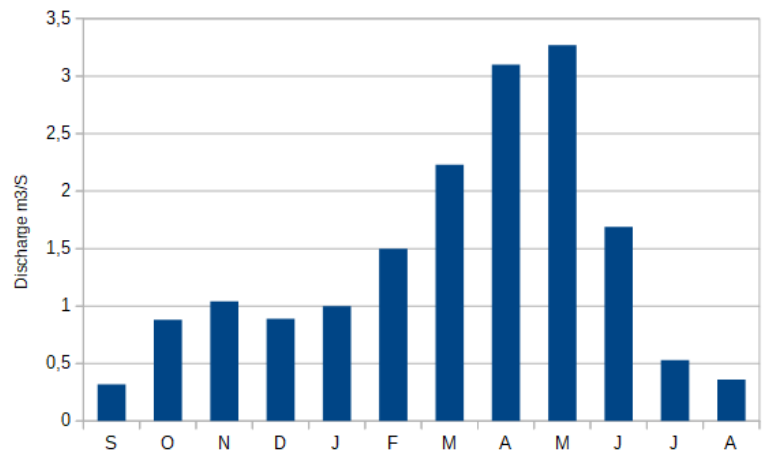
Figure 2. Mean monthly discharge (m 3 /s) of the Rheraya River at Tahanaout (river discharge data from the Agence du Bassin Hydraulique du Tensift